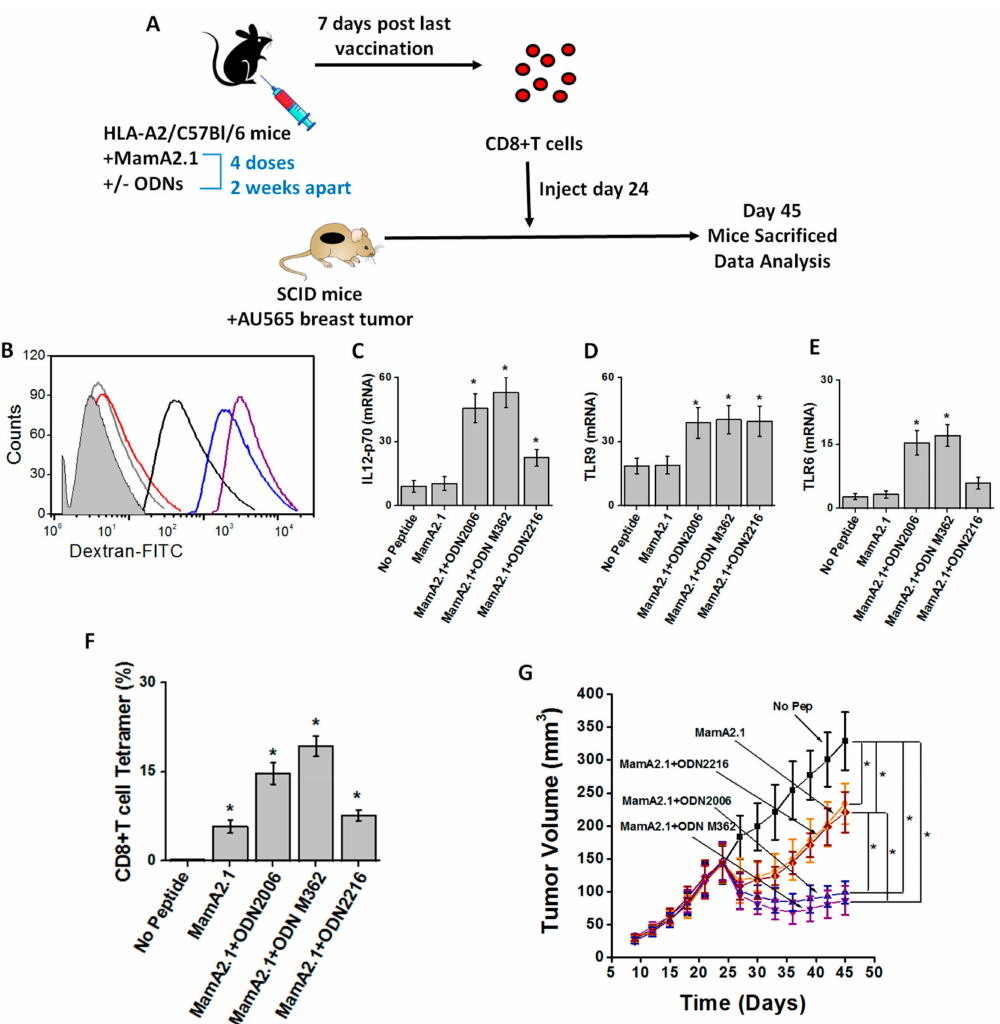
Figure 8. In vivo reduction in tumor progression following adoptive transfer of CD8 + T lymphocytes from the MamA2.1 peptide vaccinated mice with co-treatment of ODN2006 and M362. ( A ) Schematic of the murine tumor experiments. ( B ) Dextran uptake assay to determine phagocytic activity of the peritoneal macrophages from HLA-A2 +/ C57Bl / 6 mice co-treated with the MamA2.1 peptide vaccination with and without the three ODNs; (light gray) no peptide—regular culture conditions; (red) MamA2.1 peptide alone; (magenta) MamA2.1 + ODN2006; (blue) MamA2.1 + ODN M362; and (black) MamA2.1 + ODN2216. IL-12 cytokine release ( C ), expression of TLR-6 ( D ) and -9 ( E ) in